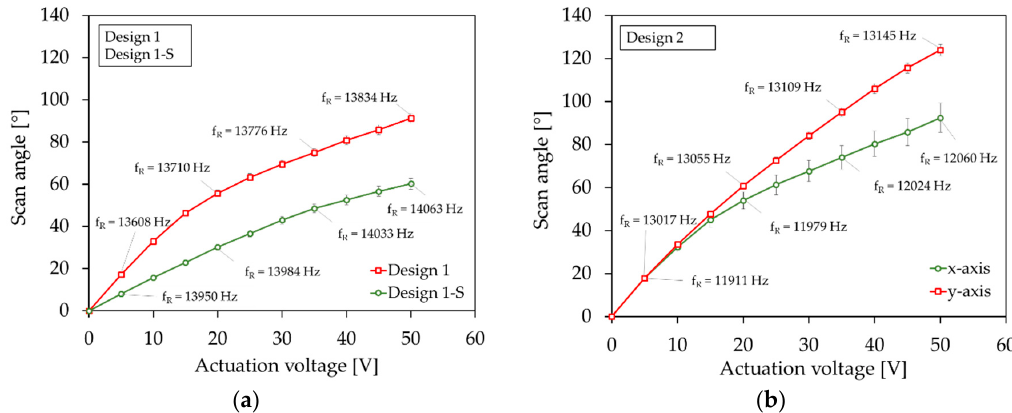
Figure 22. Resonant scan angle versus actuation voltage: ( a ) Design 1 and Design 1-S; ( b ) Design 2. The y-axis error bar is the median absolute deviation.